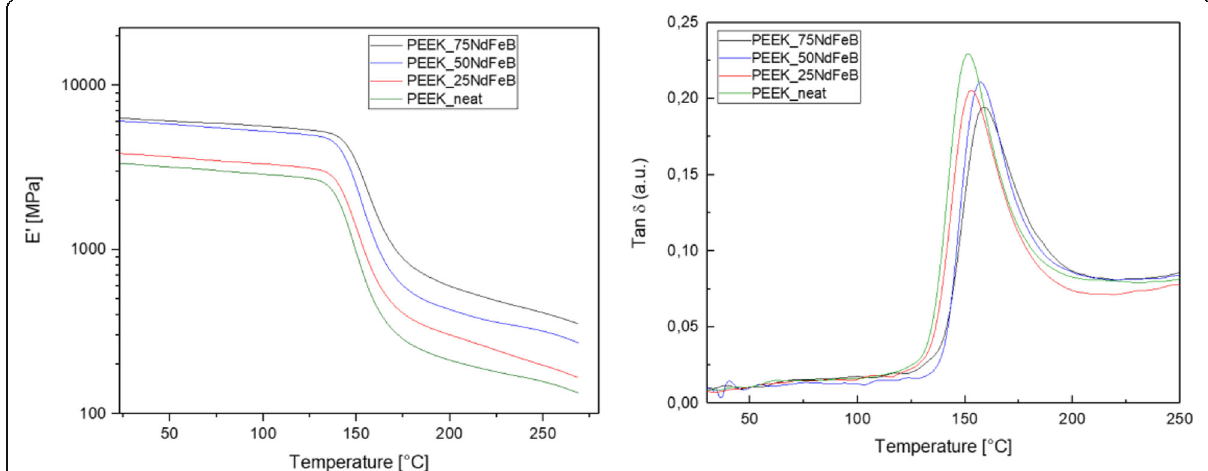
Fig. 5 DMTA results: Storage modulus (left) Tan δ (right) of PEEK_NdFeB filaments